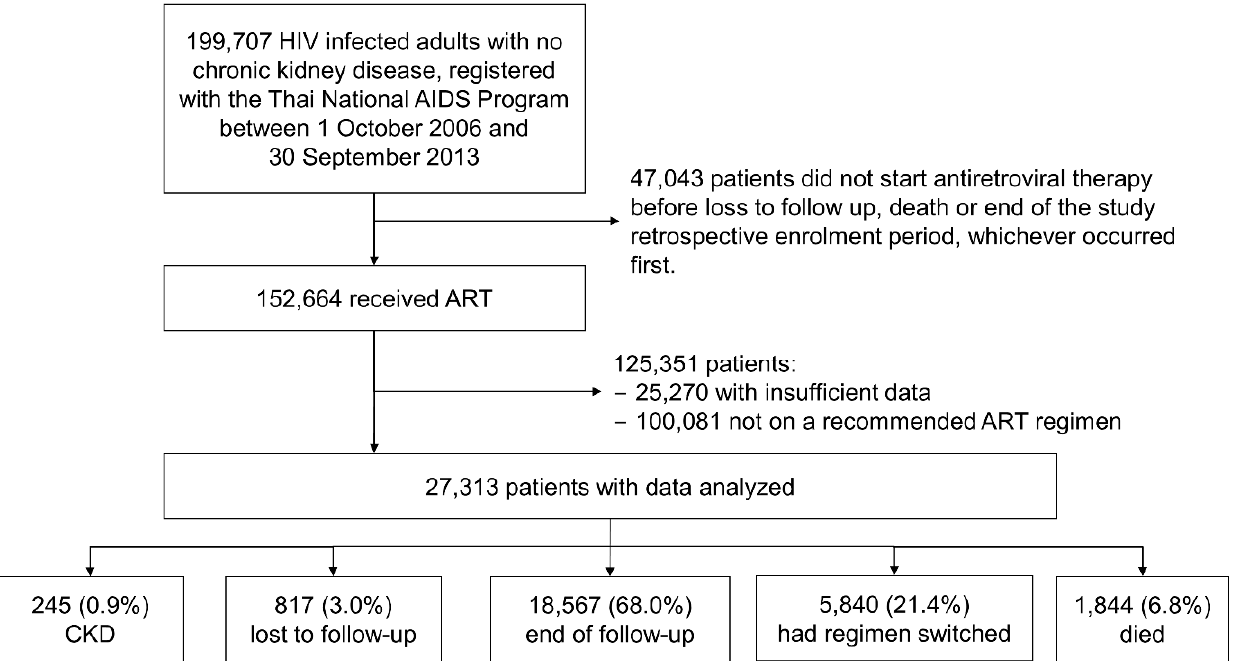
Figure 1. Patients’ disposition: reasons for patient selection for retrospective participation in the study analyses. Abbreviations: AIDS, acquired immunodeficiency syndrome; ART, antiretroviral therapy; CKD, chronic kidney disease; HIV, human immunodeficiency virus.